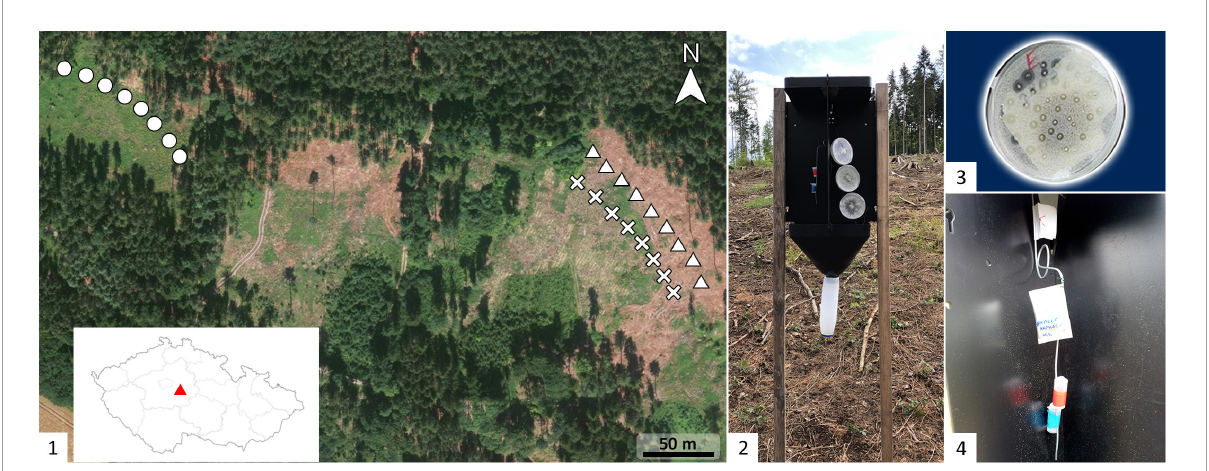
FIGURE1 Experimental field site and trap design. (1) Location within the Czech Republic and arrangement of traps for live fungal bait experiment in 2019 (circles) and in 2020 (crosses); synthetic volatile organic compounds (VOCs) bait experiment in 2020 (triangles). (2) Cross-vane trap baited with Petri dish dispensers containing actively growing fungus and I. typographus pheromone components, 2-methyl-3-buten-2-ol and cis -verbenol. Close-up view of (3) perforated Petri dish dispenser, which was hung in the trap together with pheromone components, and (4) dispenser with synthetic fungal compounds and